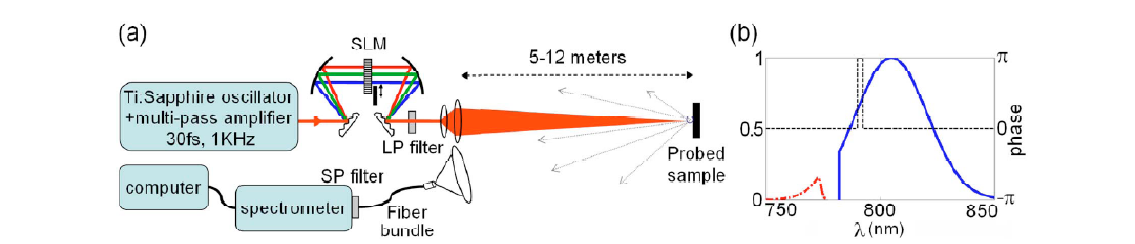
Figure 13 . CARS spectra from [60]. Resolved femtosecond CARS vibrational spectra